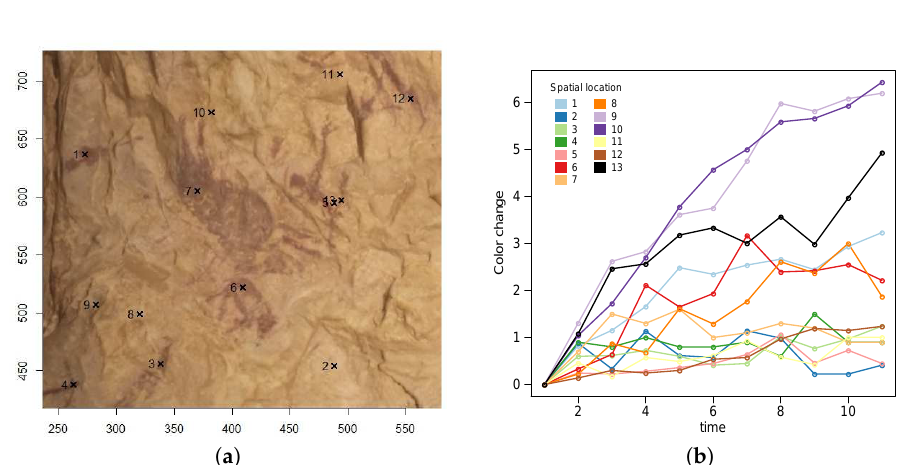
a color image of the study area; each location incorporates color fading time series of observations (Figure 2, right plot).